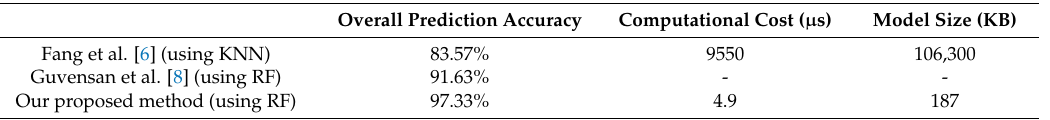
Table 13. The prediction accuracy of the proposed method and the previous studies on the dataset of HTC company [46]. The notion “-” indicates that data is not